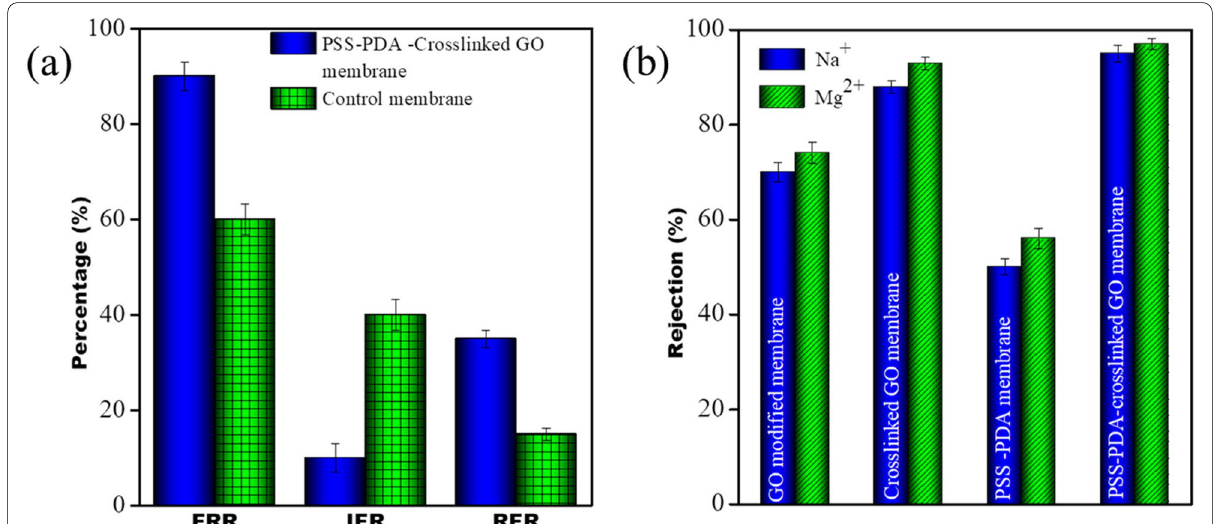
Fig. 10 Antifouling studies of control and PSS-PDA-crosslinked GO membrane in Dynamic conditions ( a ) and rejection of salts by modified membranes ( b